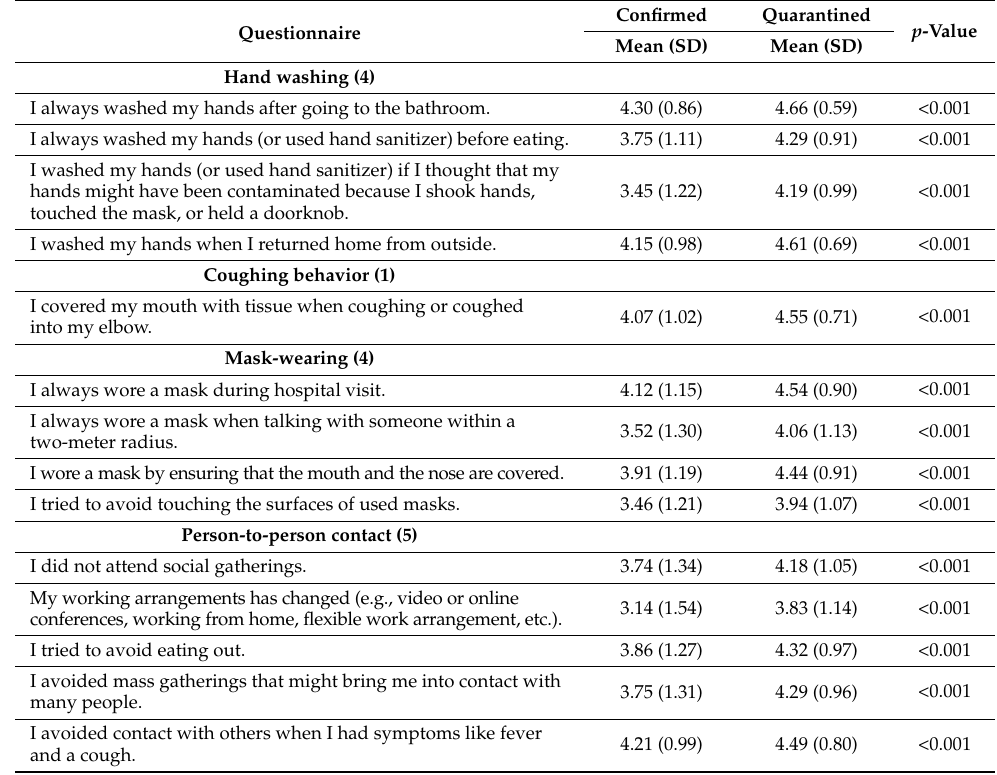
Table 4. Precautionary behavioral survey response results